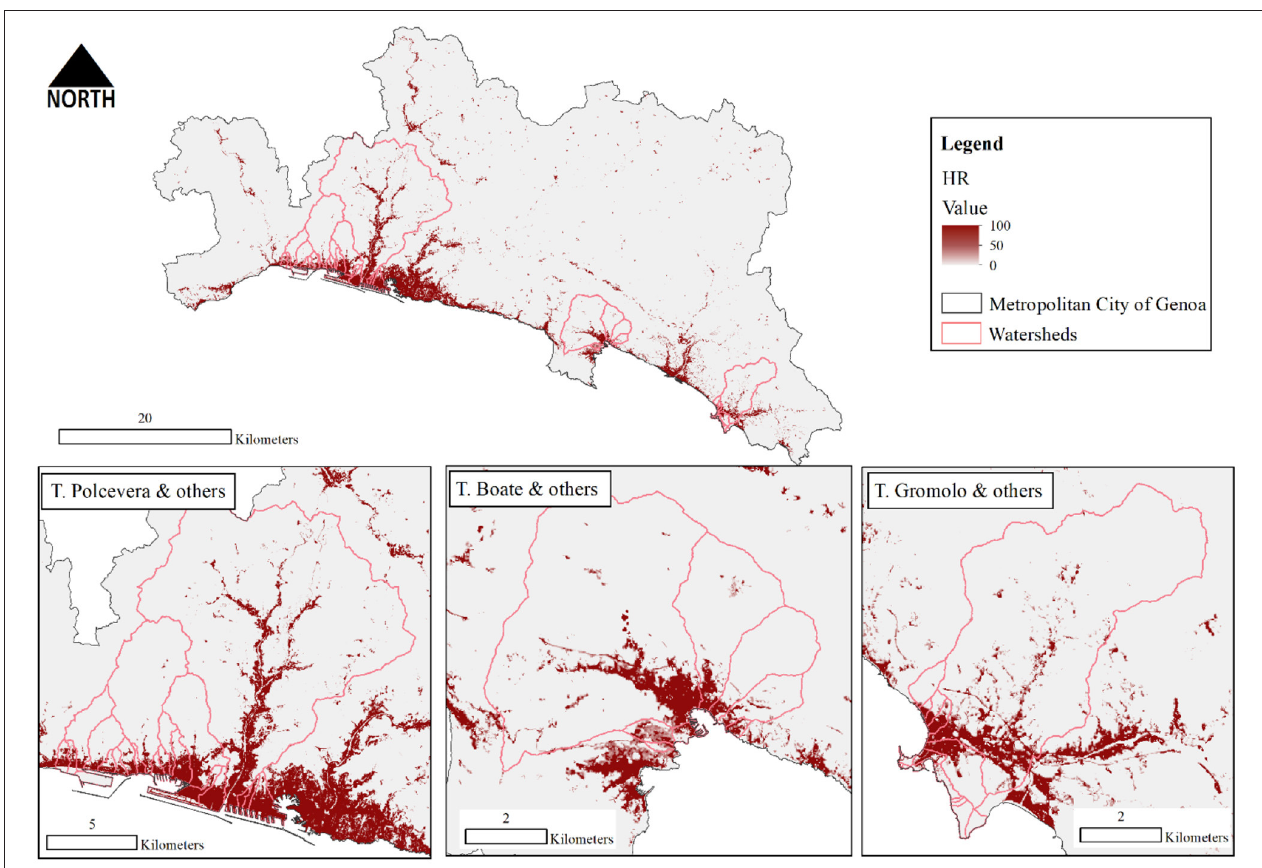
FIGURE 2 | Imperviousness HRL (High resolution layer) map (source: authors).